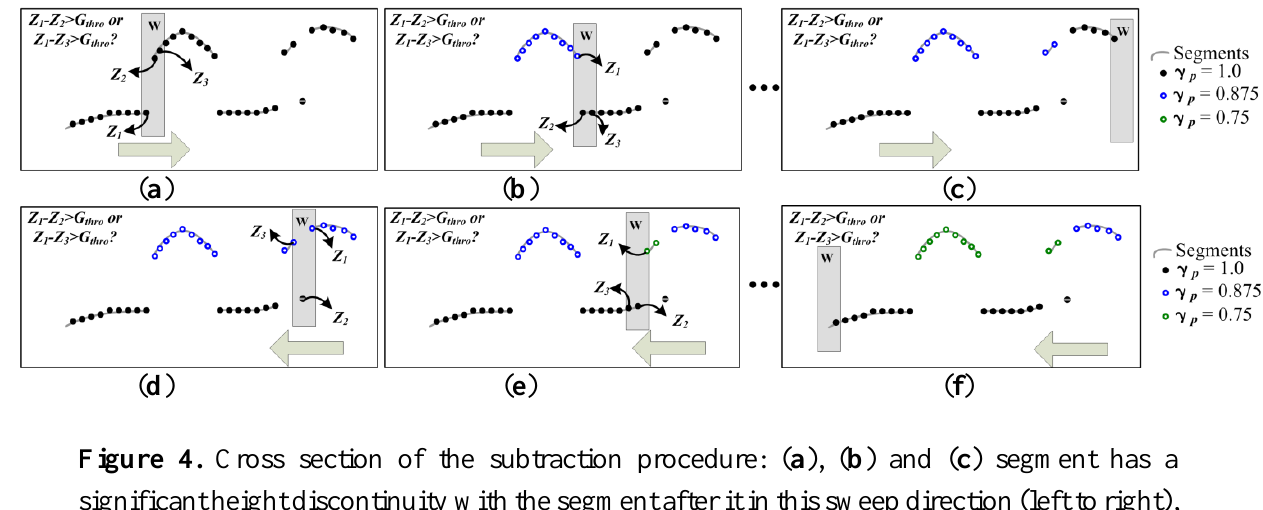
Figure 3. Cross section of the segmentation procedure when the window is swept from left to right: ( a ) cross section of a given row from the regular grid; ( b ), ( c ) and ( d ) grid cell points are segmented into different segments according to height difference with the grid cell points before them; and ( e ) segmentation result.